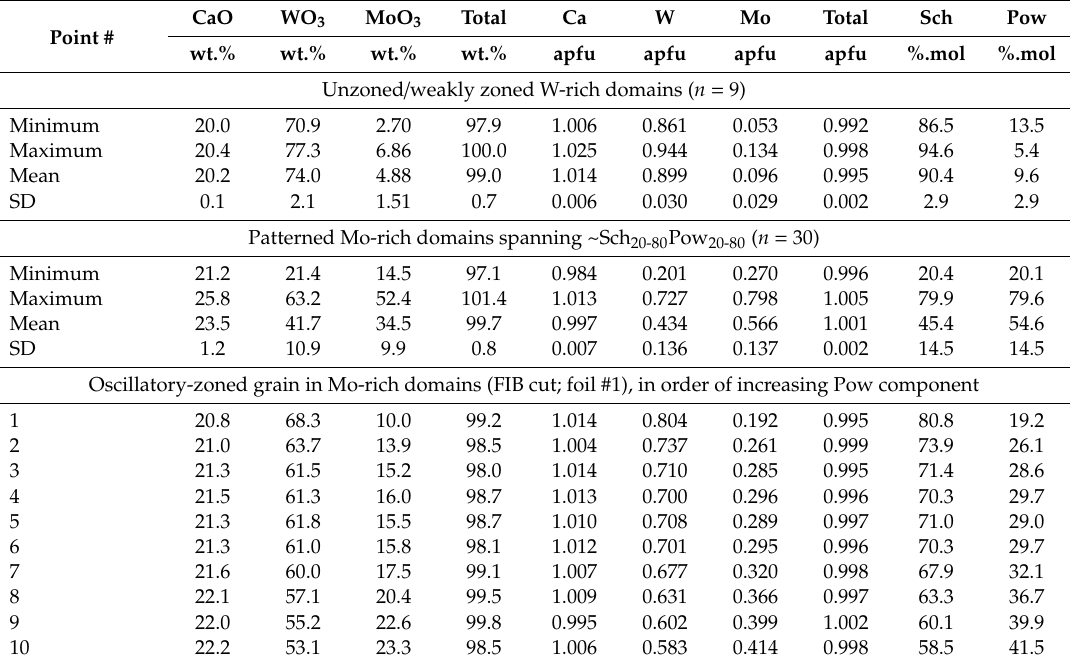
Table 1. EPMA data for Zhibula